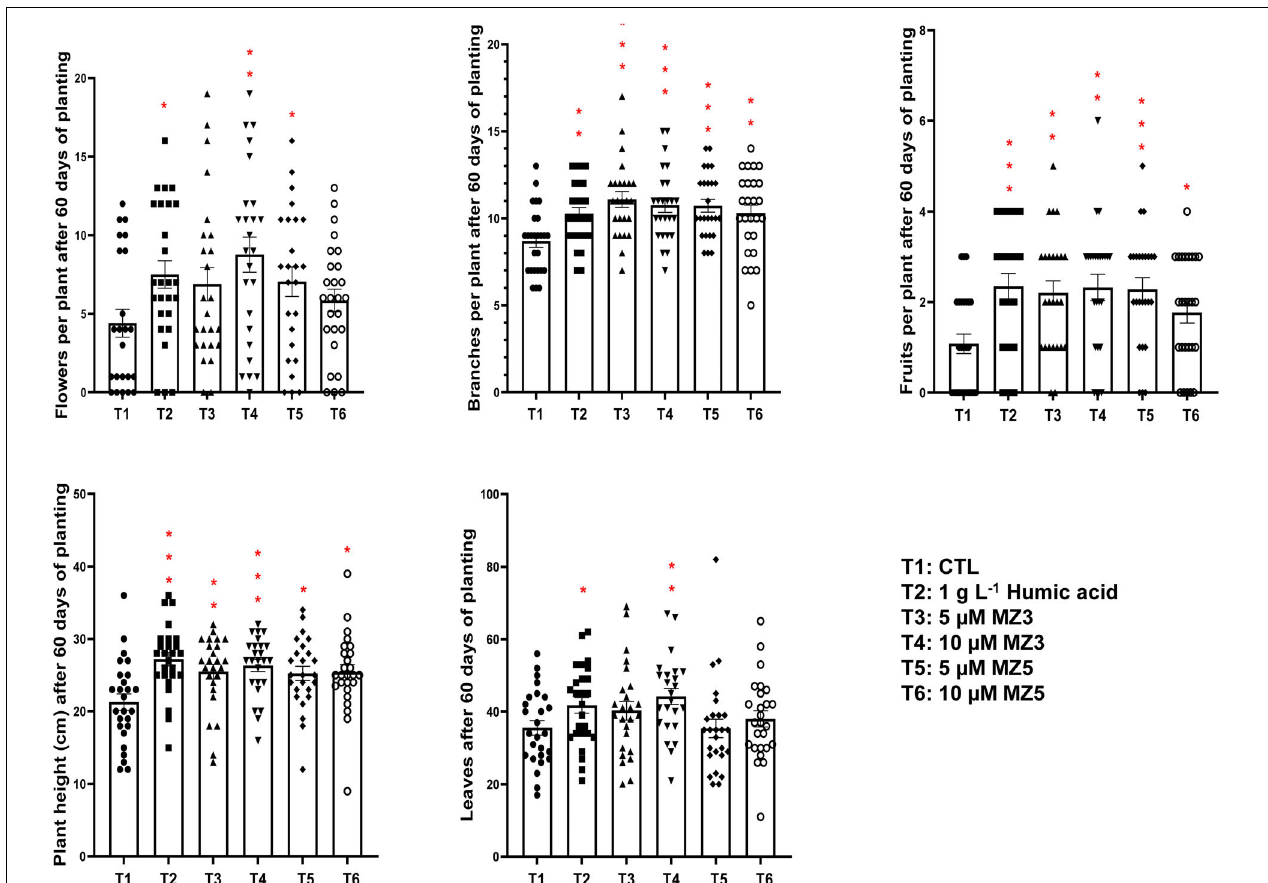
FIGURE 6 | Plant phenotypical evaluation of MiZax treatment on green pepper from the King Abdullah University of Science and Technology (KAUST) field, performed in 2021. Each data point represents one plant ( n ≥ 25). Data represent mean ± SD . Statistical analysis was performed using the two-tailed Student’s t -test. Asterisks indicate statistically significant differences as compared with CTL (* p < 0.05, ** p < 0.01, *** p < 0.001). Symbols ( • , CTL; (cid:4) , 1.5 g l − 1 HA; (cid:78) , 5 µ M MZ3; (cid:72) , 10 µ M MZ3; (cid:7) , 5 µ M MZ5; and , 10 µ M MZ5) used over error bars represent each replicates in the investigated group. CTL, Control; HA, humic acid; MZ3, MiZax3; MZ5, MiZax5. (cid:35)